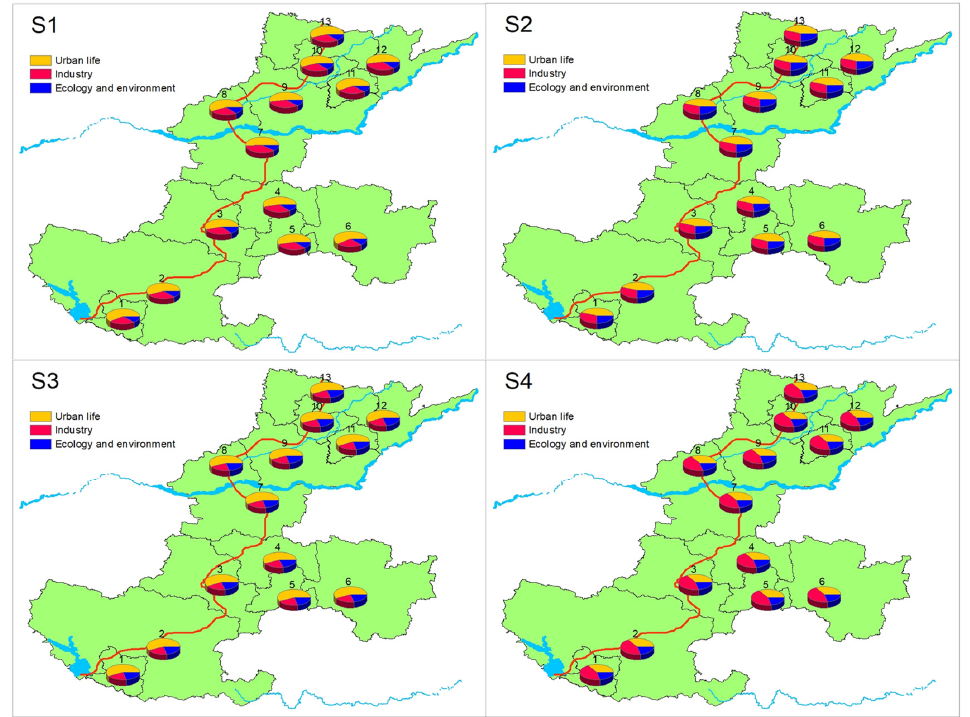
Figure 5. Water distribution proportions under different scenarios in different departments (%). Note: S1, Scenario 1; S2, Scenario 2; S3, Scenario 3; S4, Scenario 4; 1, Dengzhou City; 2, NanyangCity; 3, Pingdingshan City; 4, Xuchang City; 5, Luohe City; 6, Zhoukou City; 7, Zhengzhou City; 8, Jiaozuo City; 9, Xinxiang City; 10, Hebi City; 11, Huaxian County; 12, Puyang City; 13, Anyang City.